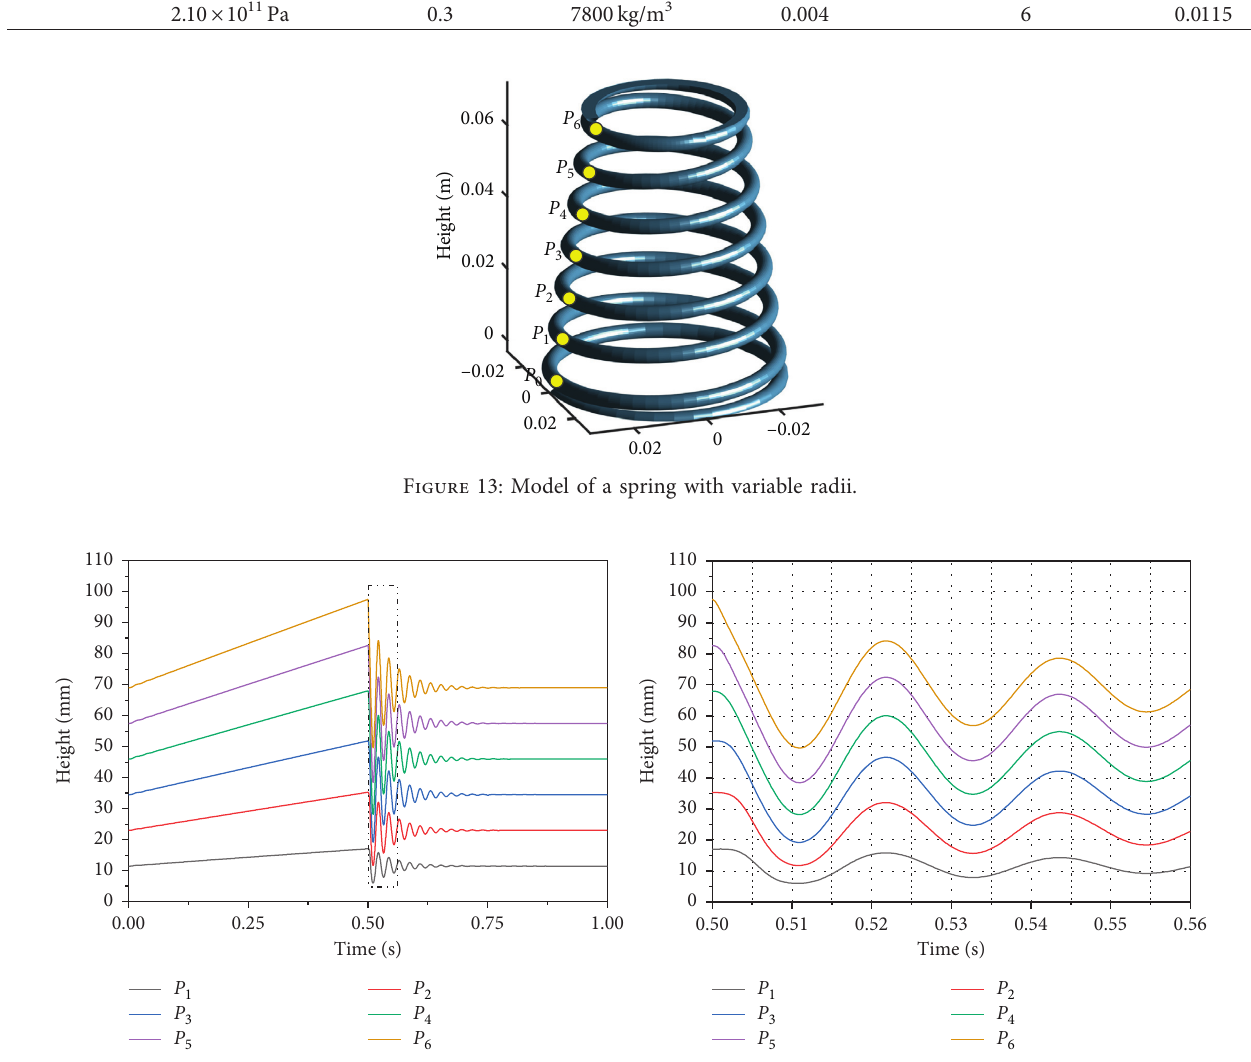
Figure 14: Time evolution of the displacement at each spring coil endpoint.